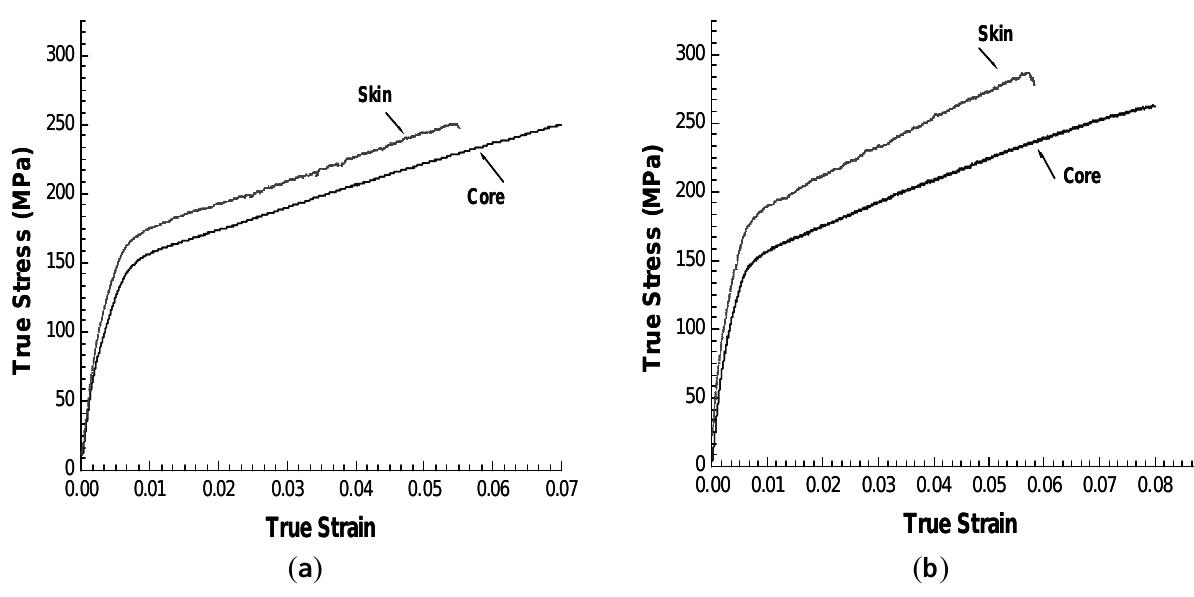
Figure 5. Stress-strain curves of skin and core of specimens extracted from two different regions